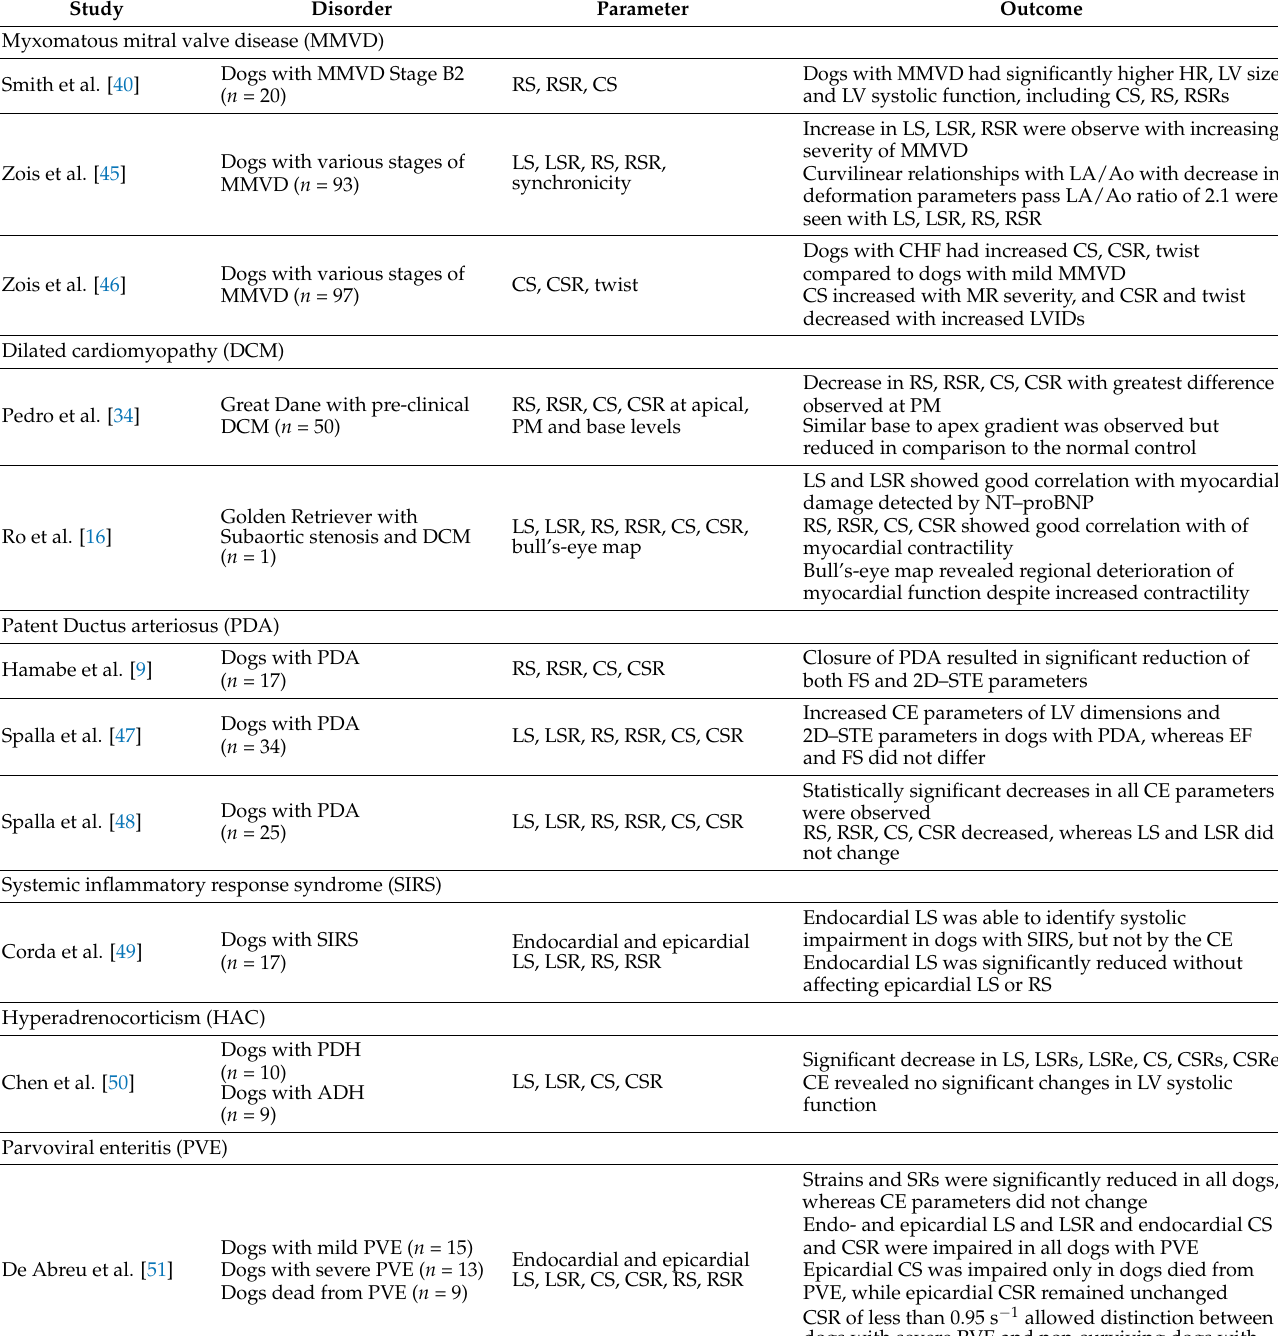
Table 3. Clinical studies evaluating LV myocardial function in various disorders in dogs using two-dimensional speckle tracking echocardiography